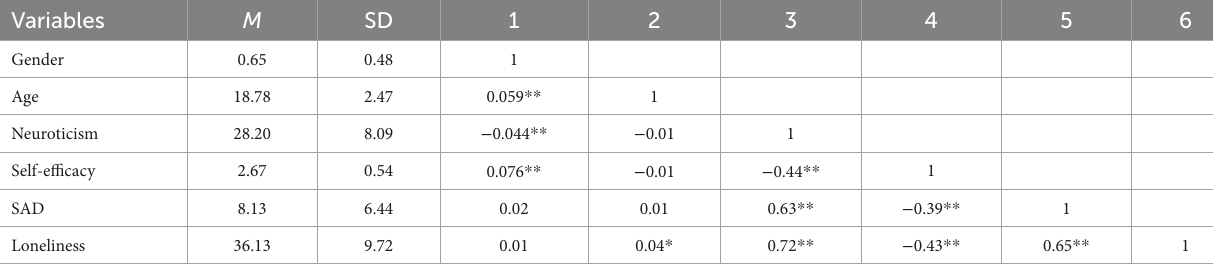
TABLE 3 The result of data’s description and correlation